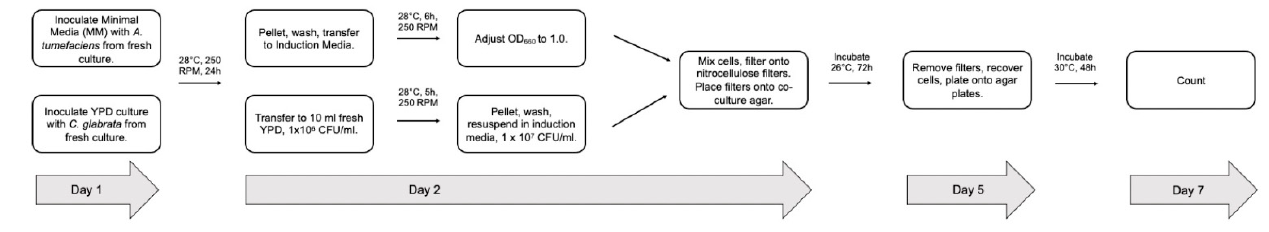
Figure 1. Flowchart of the ATMT protocol.